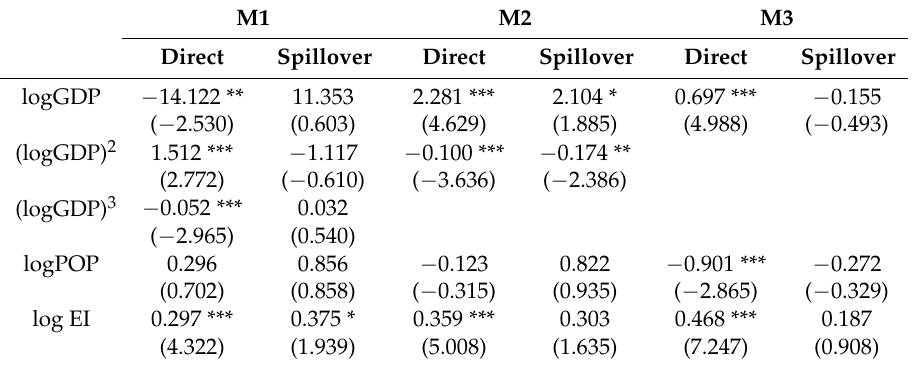
Table 6. Direct and spillover effects estimation (gross domestic product as the indicator of affluence).